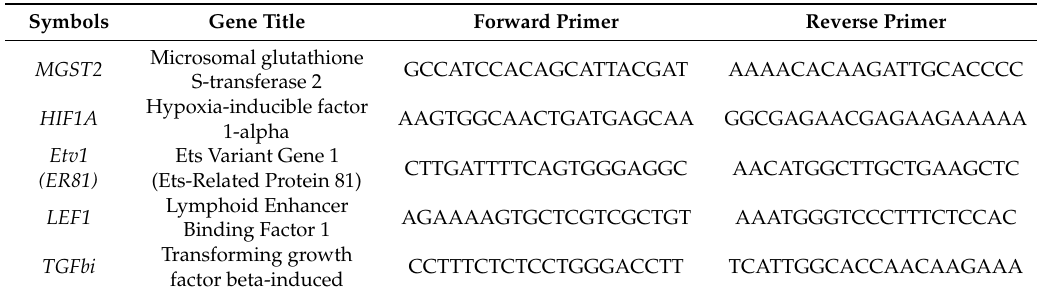
Table 2. Primer sets designed for reverse-transcription qPCR in the validation